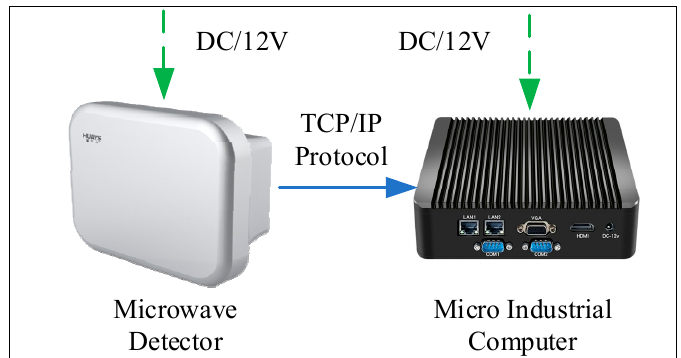
8 of 20 Figure 2. The installation point and observation area of the microwave detector. The roadside observation data collection system was composed of a wide-area microwave detector, a micro industrial computer, and a power supply, as shown in Figure 3. The wide-area microwave detector supported multi-target trajectory tracking detection in multiple lanes, and the longitudinal view reached 300 m (model: DTAM D29; item: wide-area radar microwave vehicle detector; manufacturer: Nanjing Huiershi Intelligent Technology Co., Ltd., Nanjing, China). In the experiment, the detector was set to output basic information, such as longitudinal position, lateral position, longitudinal speed, lateral speed, and the ID and time stamp of the vehicles in the observation area at a frequency of 1–20 Hz. The micro industrial computer used the network transmission